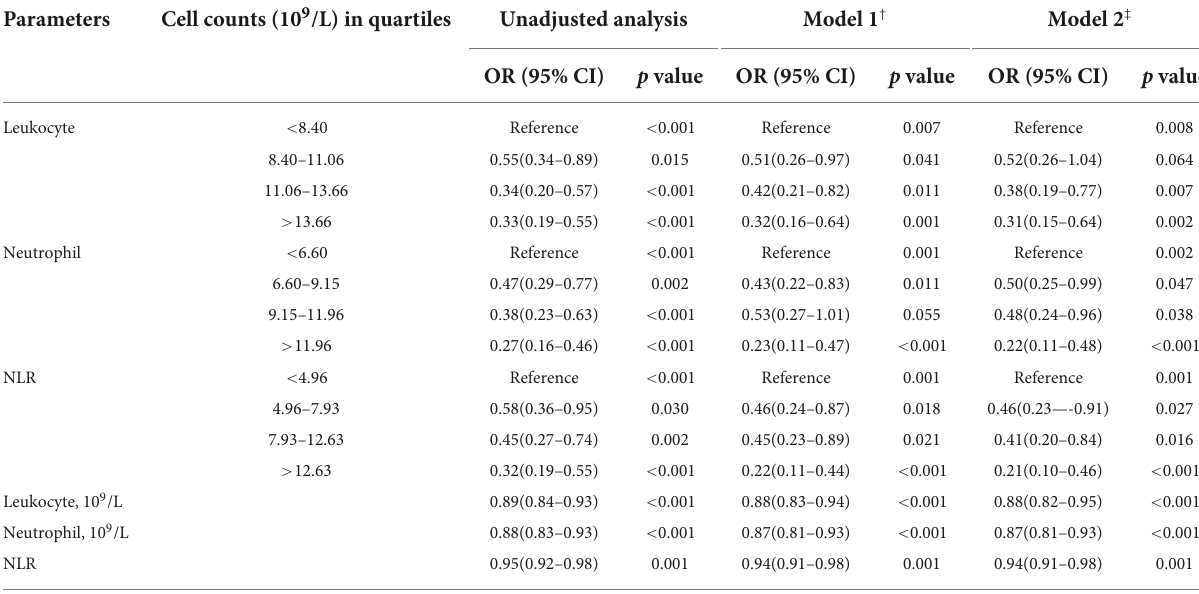
TABLE 2 Unadjusted and adjusted analyses of neutrophil count ( × 10 9 /L), leukocyte count ( × 10 9 /L), NLR with mRS 0–2 at 90days.